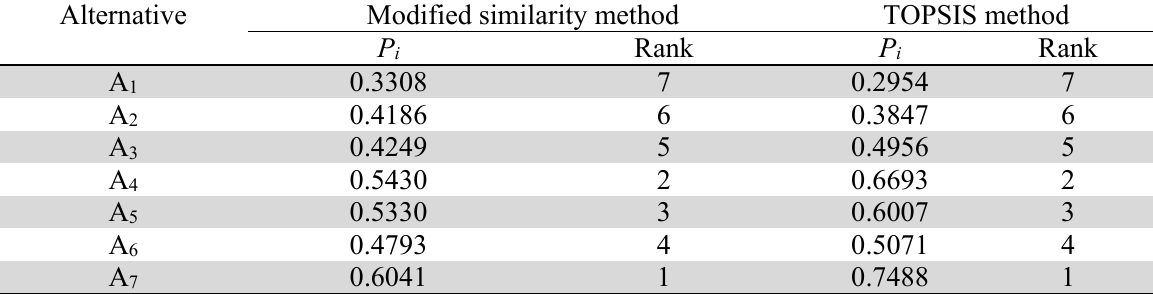
Comparison between modified similarity and TOPSIS methods for neat oil selection problem Alternative